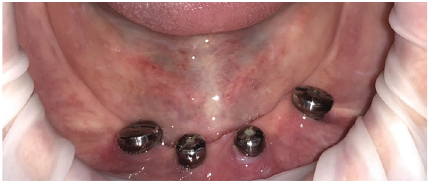
Figure 5: Healing abutments in